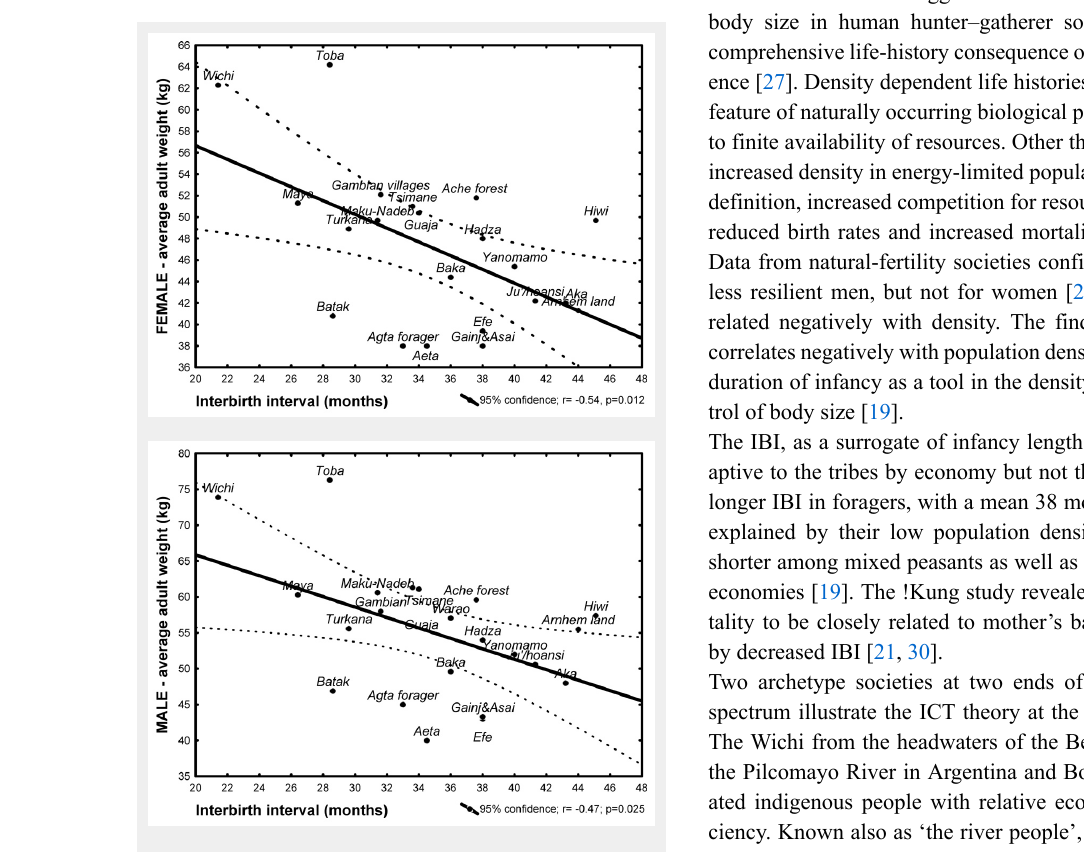
Figure 2 Interbirth interval (IBI) and adult size. The regression line and the 95% confidence limits for the adult body-weight in women (a) and men (b) as a function of IBI in traditional societies